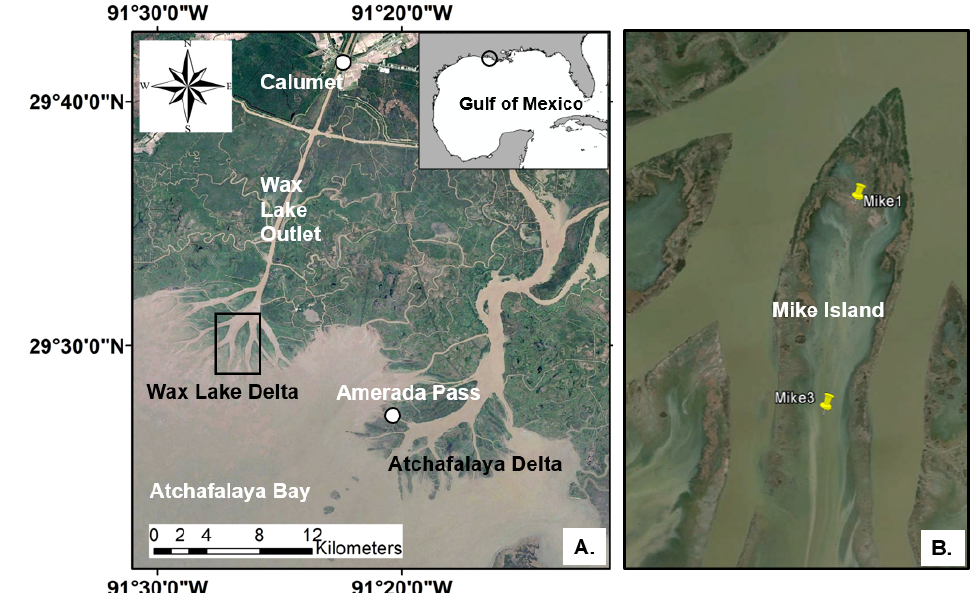
Figure 1. ( A ) Map of the National Oceanic and Atmospheric Administration (NOAA) Amerada Pass (NOAA-8764227) wind and the United States Geological Survey (USGS) Calumet (USGS-07381590) discharge stations in relation to Mike Island on the Wax Lake Delta. Black rectangle displays the extent of panel ( B ). The circle in the Gulf of Mexico inset shows the overall study area. ( B ) Observational / sampling stations Mike1 and Mike3 are located ~1.5 km apart. Base maps in ( A ) and ( B ) are both from Google Earth.